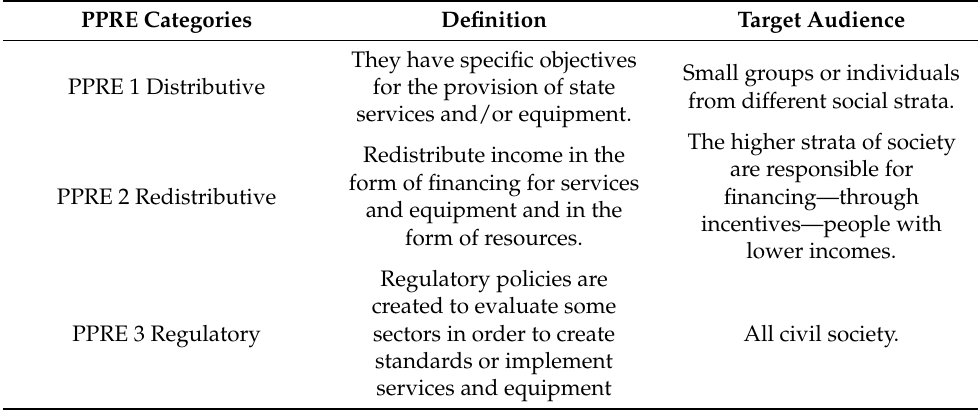
Table 1. Overview of public policy categories corresponding to their social aspects according to Lowi’s classification